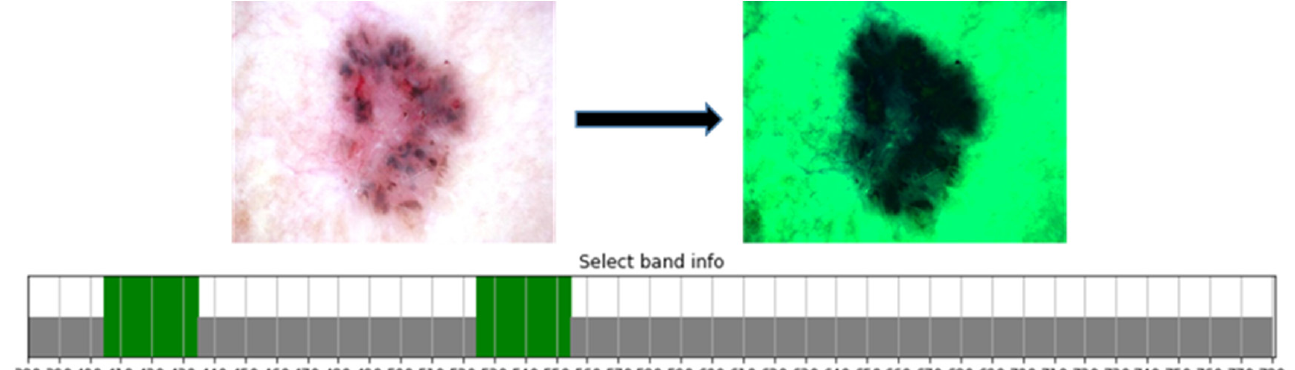
Figure 6. Bands 380–780, 405–435, and 525–555 nm between the 401 channels are selected and extracted. Two data sets were obtained using the RGB and HSI images. The training and test sets need to be divided. Hence, 80% of the data was divided for training while the remaining 20% of the data were used for testing the model after image amplification